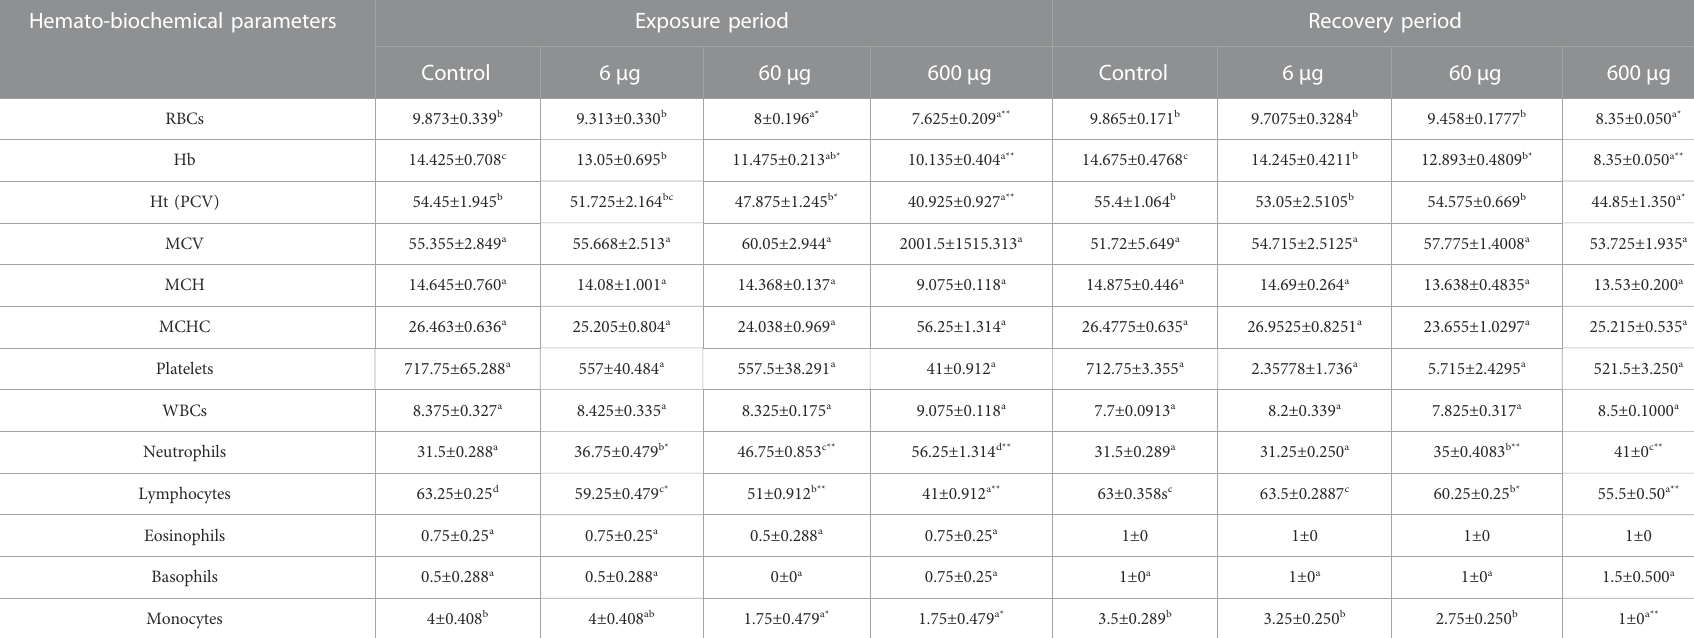
TABLE 3 Effect of 15 days of exposure to microplastics (MPs) and recovery on the hematological characteristics of the C57BL/6 mouse model. Data are represented as means ± SE. Values with different superscript letters inthe same row for each parameter are signi fi cantly different ( p < 0.05). Values of recovery period with * are signi fi cantly different from exposure period. Hemato-biochemical